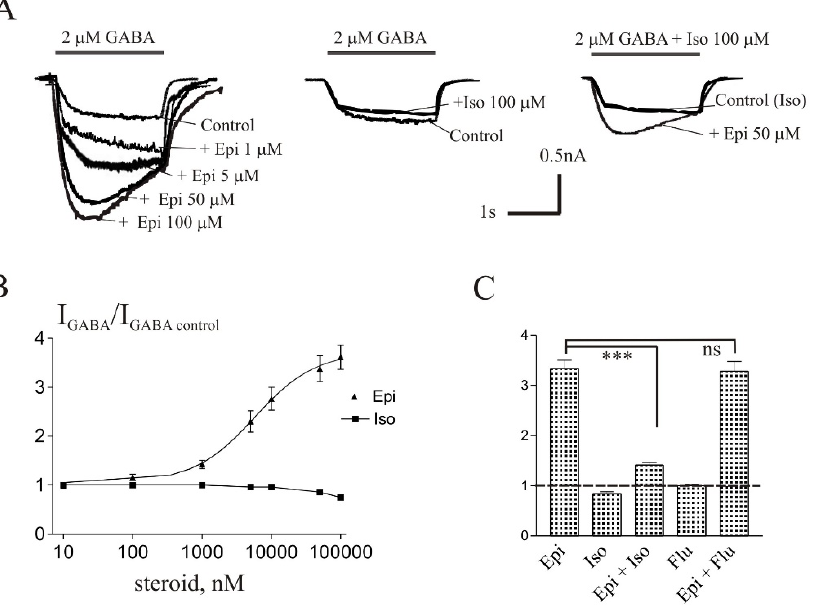
Figure 2. Iso antagonizes the potentiation of I GABA induced by Epi in Purkinje cells. ( A ) Representa- tive traces of the current induced by 2 µ M gamma-aminobutyric acid (GABA) in control and during co-application with different concentrations of Epi (left), 100 µ M Iso (middle) and 50 µ M Epi together with 100 µ M Iso (right). ( B ) Concentration dependence of Epi and Iso effect on the normalized peak amplitude of I GABA . ( C ) Mean ± standard error of the mean (SEM) of the normalized values of the peak amplitude of I GABA in the presence of Epi (50 µ M), Iso (100 µ M), Epi + Iso, flumazenil (10 µ M), Epi + flumazenil. The control value is indicated by a dashed line. Data points represent average from seven cells. *** Means p < 0.001, ns means not significant.